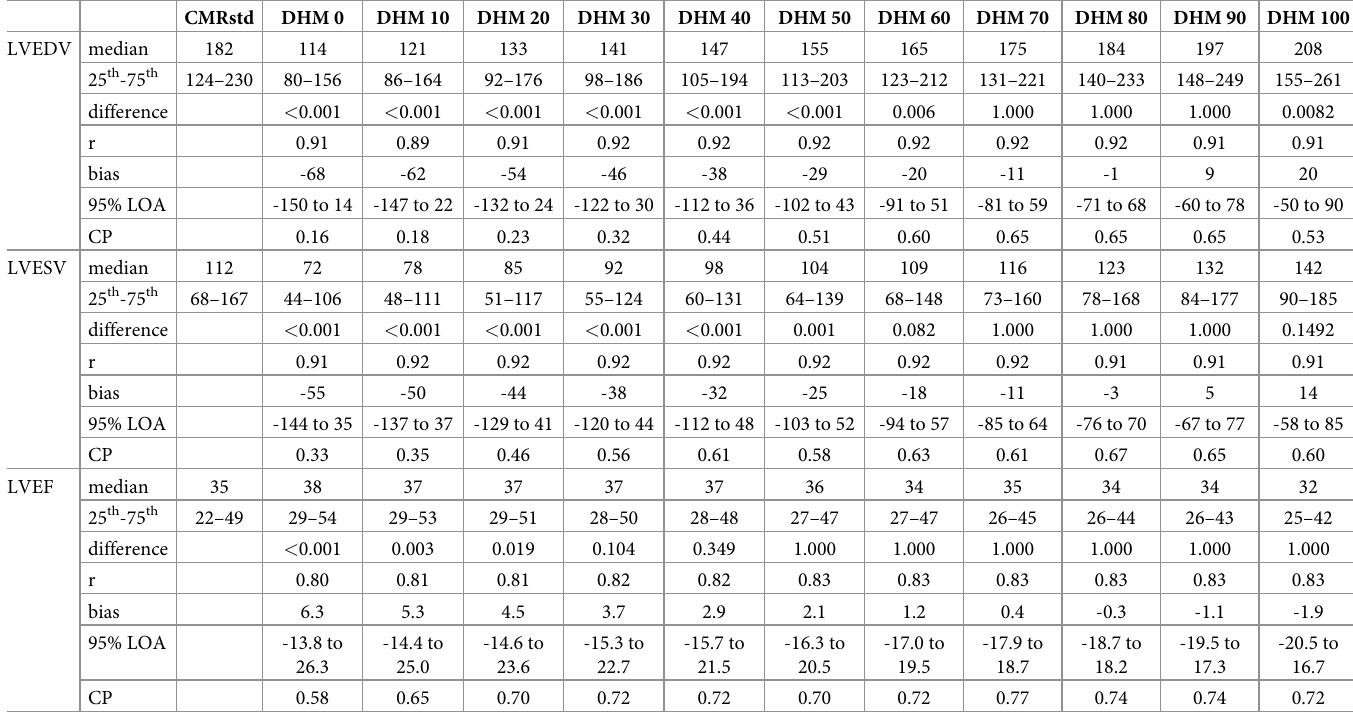
Table 2. Comparison of LV volumes and EF between Dynamic HeartModel and CMR disk-area summation method (n =